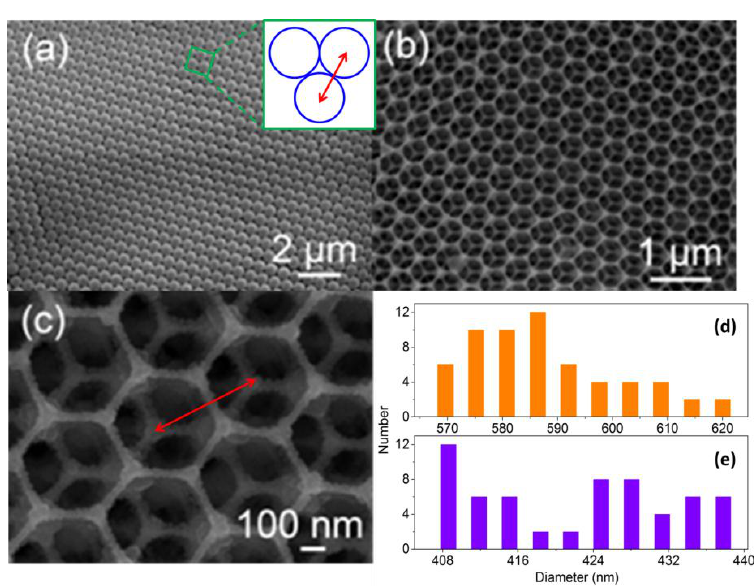
Figure 4. SEM images of ( a ) PMMA sphere opal films, ( b ) 3DIO WO 3 sample, and ( c ) the enlarged SEM images of 3DIO WO 3 on the glass substrate. ( d , e ) The size distribution of the PMMA spheres and 3DIO WO 3 center-to-center distance, and the size distribution were estimated by measuring 60 cells. The inserted picture of ( a ) is the enlarged scheme of the PMMA in the green box. The red arrows in ( a , c ) revealed the center-to-center distances of PMMA spheres and 3DIO WO 3 , respectively.